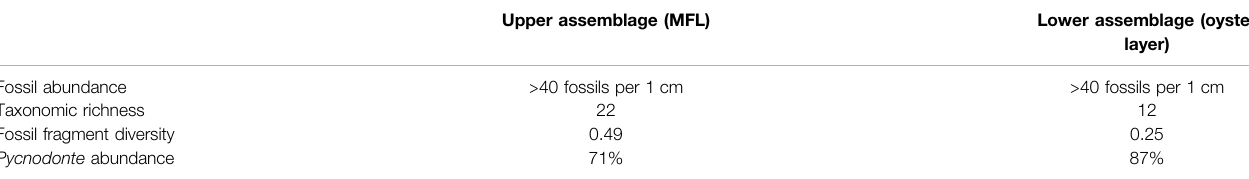
TABLE 2 | Summary of fossil abundance, taxonomic richness, fossil fragment diversity (calculated as Simpson Diversity Indices), and percent of faunal composition representedby Pycnodonte oystersforeachfossilassemblageidenti fi edherein. Thesevaluesarederivedfromcombiningdataacrosstheentirethicknessofeachlayer, with their stratigraphic bounds delineated as described in the